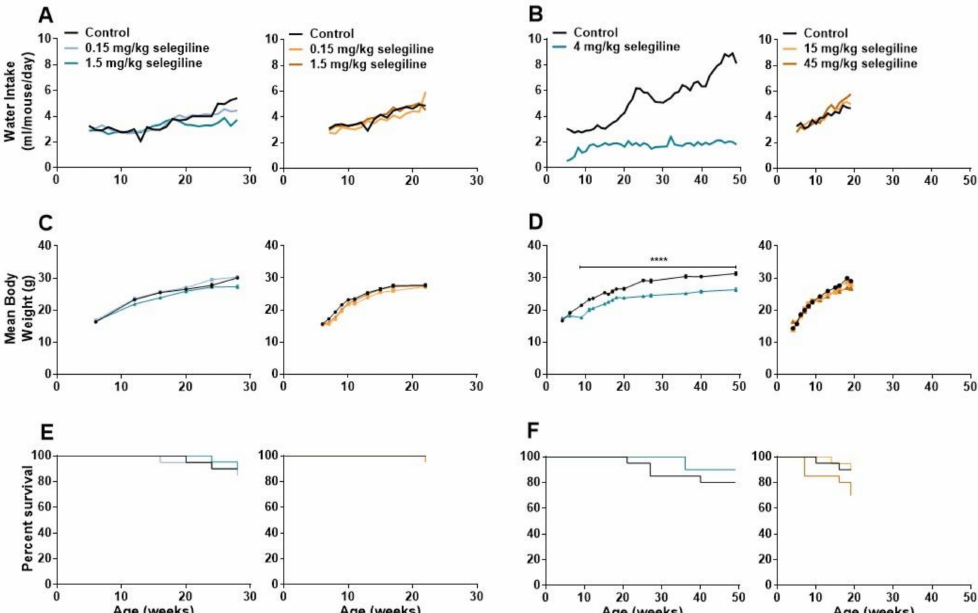
Figure 4. Changes in water consumption, body weight, and analysis of survival during the long term oral treatment by different concentrations of selegiline in BALB/c and DBA/2J mice. Selegiline was administered in tap water. The water intake/day was measured for a whole cage of 10 mice, and the ml/mouse/day values were calculated from that. ( A ) Effect of 0.15 and 1.5 mg/kg (Experiment I) and ( B ) 4 mg/kg and 15 and 45 mg/kg selegiline (Experiment II) on the water intake in BALB/c and DBA/2J mice. ( C ) Effect of the lower (0.15 and 1.5 mg/kg; Experiment I) and ( D ) higher (4 mg/kg and 15 and 45 mg/kg; Experiment II) doses of selegiline on weight gain in BALB/c and DBA/2J mice (**** p < 0.0001). ( E , F ) The Kaplan-Meier plots show the effect of different doses of per os selegiline on survival rate in BALB/c and DBA/2J mice (compared to control by Mantel-Cox and Gehan-Breslow-Wilcoxon tests; see details in